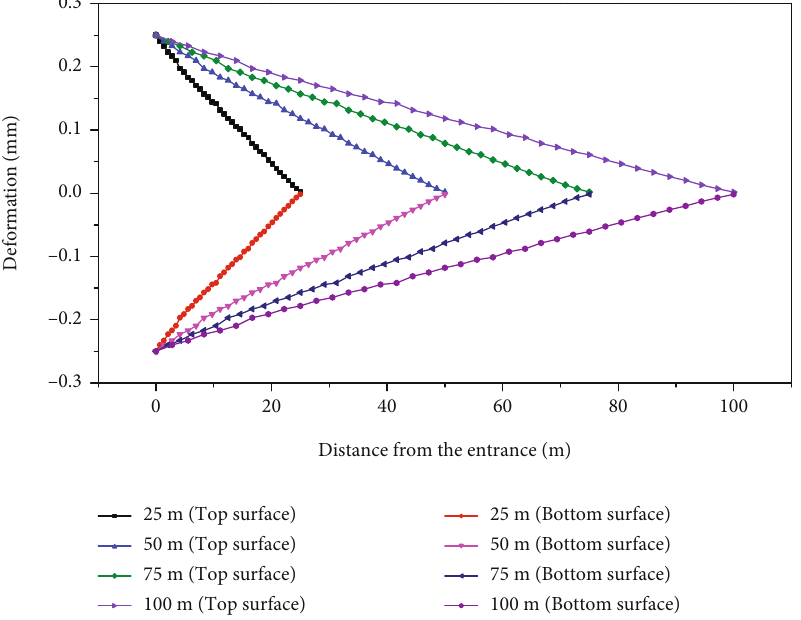
Figure 7: The displacements of aperture along the centre axis of the fracture under 2 MPa injection pressure.